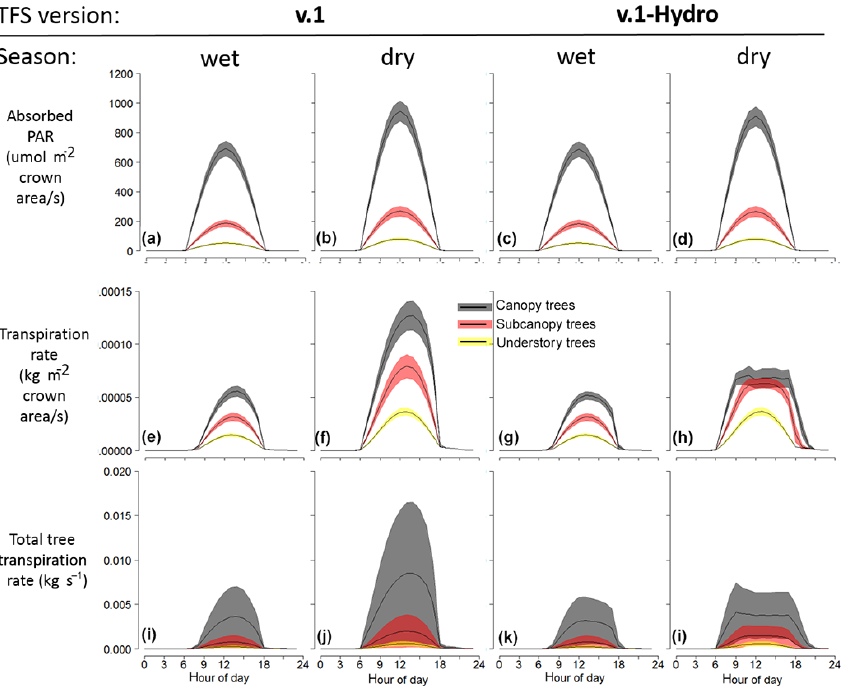
Figure 9. TFS simulated mean ( ± 1 SD) diurnal cycles across all individuals by canopy position, in wet and dry seasons with (v.1-Hydro) and without (v.1) plant hydraulics implemented, at Caxiuana, Brazil. (a–d) Total absorbed photosynthetically active radiation, (e–h) transpiration rate per unit crown area, (i–l) total tree transpiration